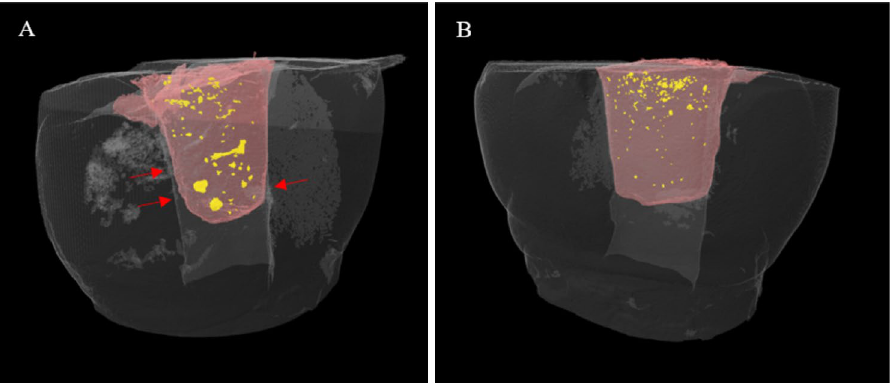
Figure 2. Representative 3D images showing the presence of voids (in yellow) in Cotton pellet ( A ) and PTFE ( B ) groups. It can be noted that with the PTFE spacer, the Cavit restoration had a flat surface over the spacer with a relatively uniform depth, compared with the cotton pellet that produced a convex restoration surface with marginal gaps (red